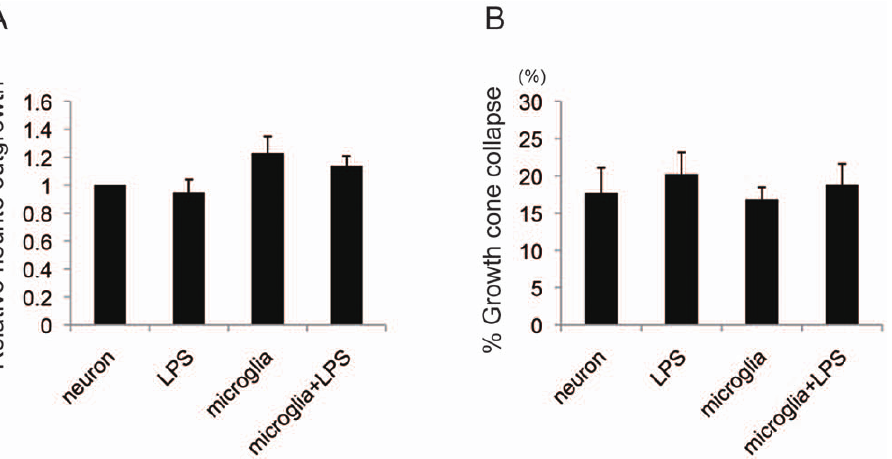
Figure 3. Cell-cell contact is necessary for activated microglia-induced neurite outgrowth inhibition and growth cone collapse. A , Results of neurite outgrowth assay across 4 treatment groups (neurons-only, neurons + LPS, neurons co-cultured with unactivated microglia, neurons co-cultured with activated microglia) in the transwell system (n=3). The neurons, seeded to the lower plane, were separately co-cultured with the unactivated and activated primary microglia, seeded to the upper plane. B , Results of growth cone collapse assay across 4 treatment groups (neurons-only, neurons + LPS, neurons co-cultured with unactivated or activated microglia) in the transwell system (n=3). Data are represented as mean 6